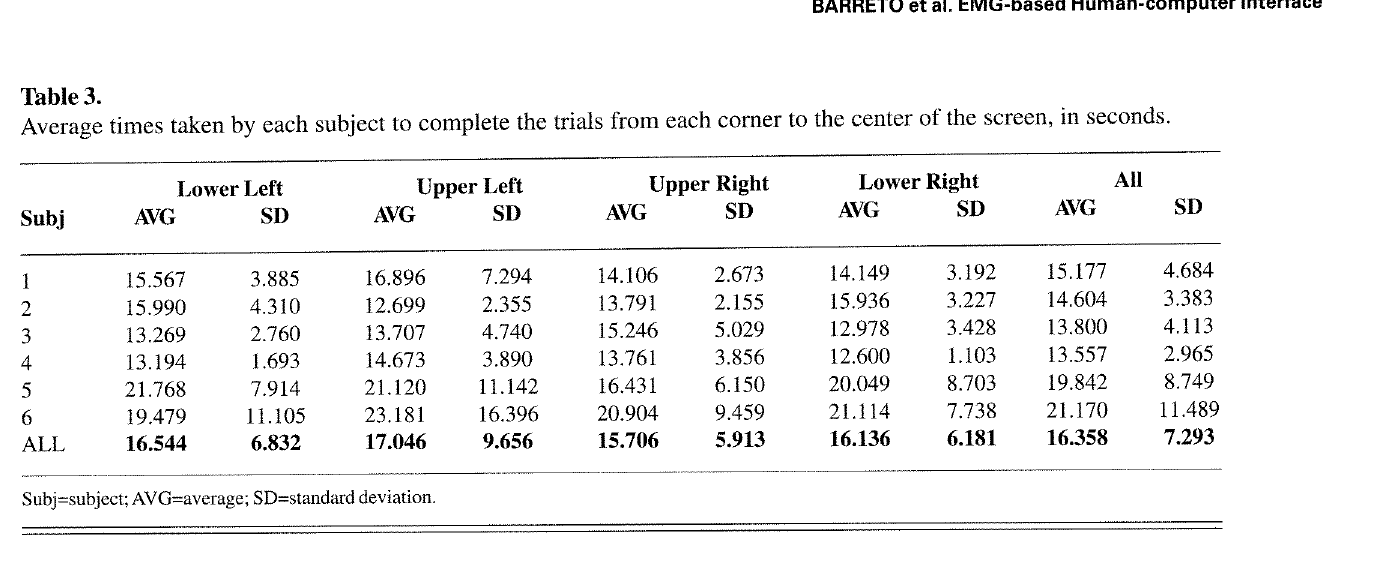
Table 3. Average times taken by each subject to complete the trials from each corner to the center of the screen, in seconds. Lower Left Upper Left Upper Right Lower Right Subj AVG SD AVG SD AVG SD AVG